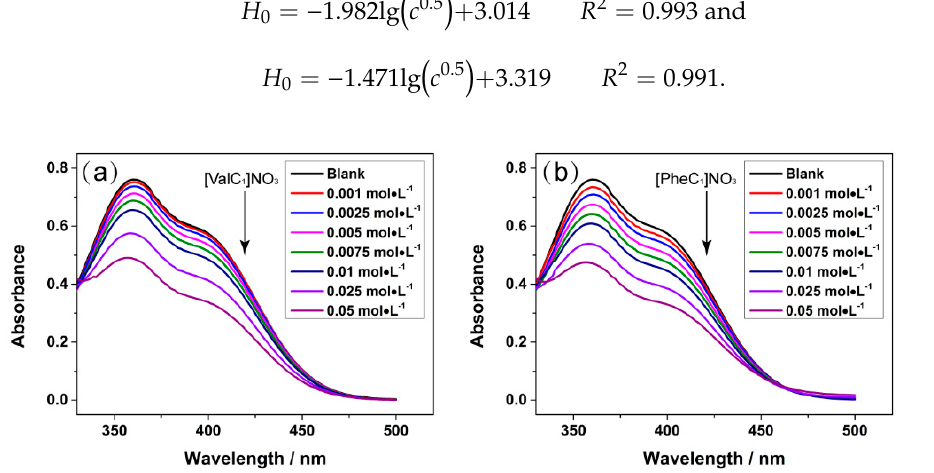
Figure 4. ( a ) The UV/Vis spectra of [ValC 1 ]NO 3 with different concentrations in water according to the Hammett method at 25.0 (±0.1) °C. ( b ) The UV/Vis spectra of [PheC 1 ]NO 3 with different concentrations in water according to the Hammett method at 25.0 (±0.1) °C. Indicator: sodium 2,4- Their nonlinear fittings are shown in Figure 5. The H 0 of [AAE]X gradually lowered with the concentration of [AAE]X rising. Based on these, the desired acidic strength can be obtained by choosing the appropriate concentrations.